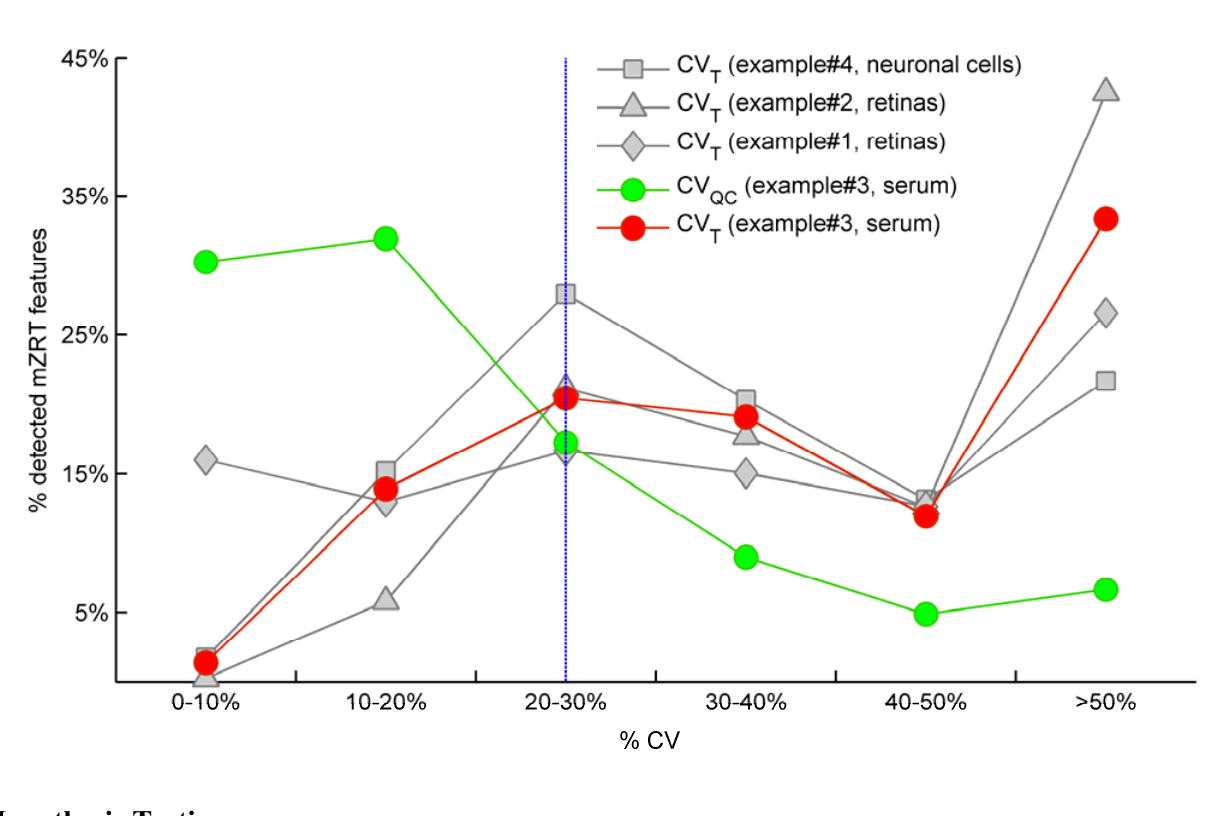
) or T ). Grey spots represent CV for examples #1(  ), #2 (  ) and #4 QC T and CV respectively for example QC T cut-off threshold established when QC samples are not T